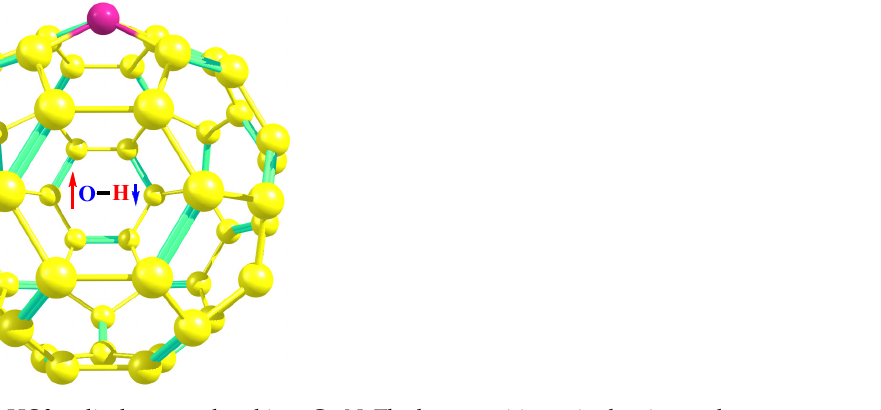
Figure 1. HO • radical encapsulated into C 59 N. The large positive spin density on the oxygen atom is indicated by the red arrow; the small negative spin density on the hydrogen atom is shown by a blue, inversely oriented arrow.